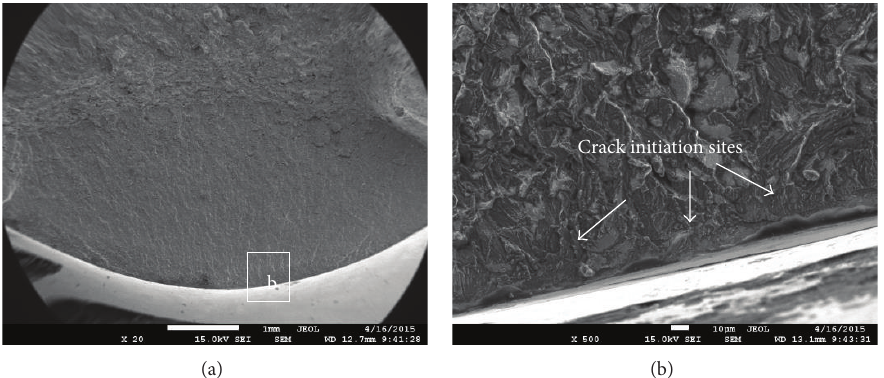
Figure 11: Fracture surface of the CNP: (a) fracture surface and (b) crack initiation sites.